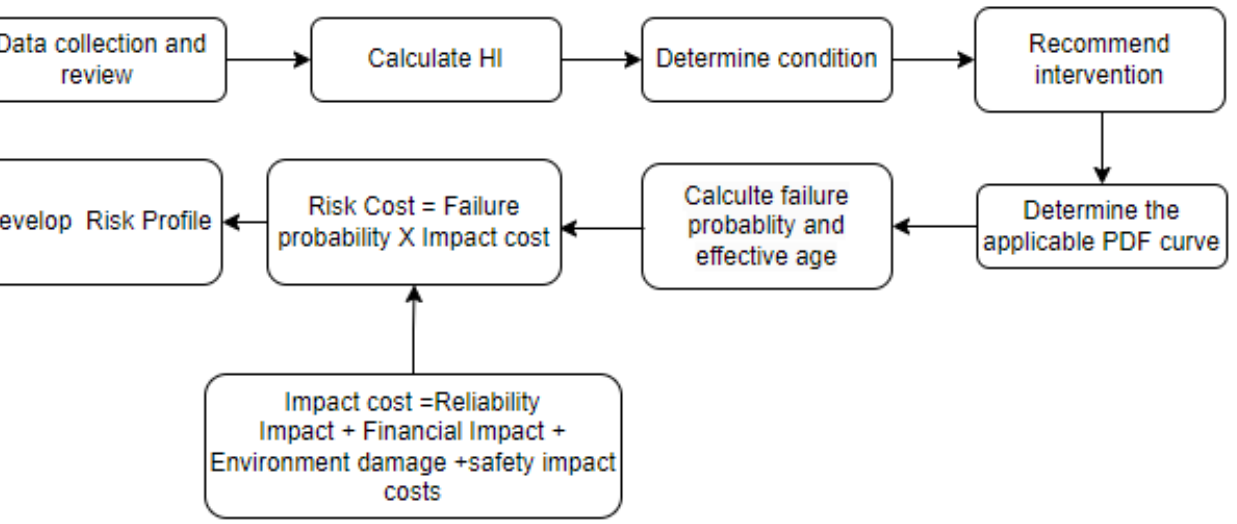
Figure 13. Process guidelines for best practice of UGPC fl eet management.